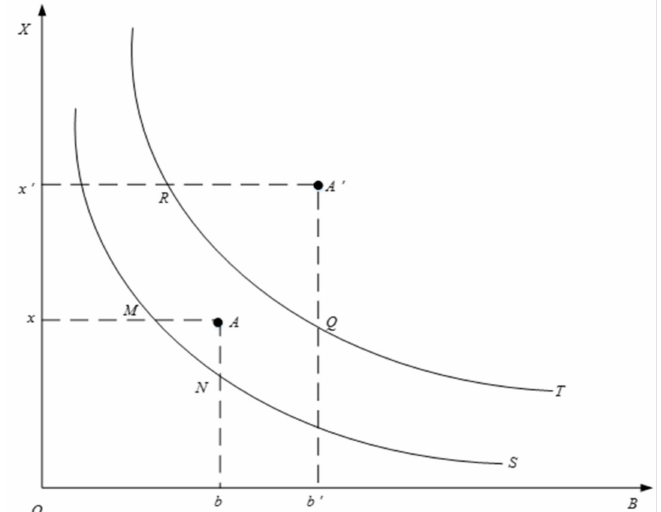
Figure 1. Plan view of the change of front surface of DMU (decision-making units) production in three-dimensional space. X is an input element, such as capital and labour. B is wastewater and exhaust gas emissions, that is, undesired output. In s period, x is the input element of Euclidean centre A , b is its undesired output, and S is the production frontier. In t period, x (cid:48) is the input of the Euclidean centre A (cid:48) , b (cid:48) is its undesirable output, and T is the production frontier. R , Q and M , N are the intersections of A and A (cid:48) with the production fronts T and S